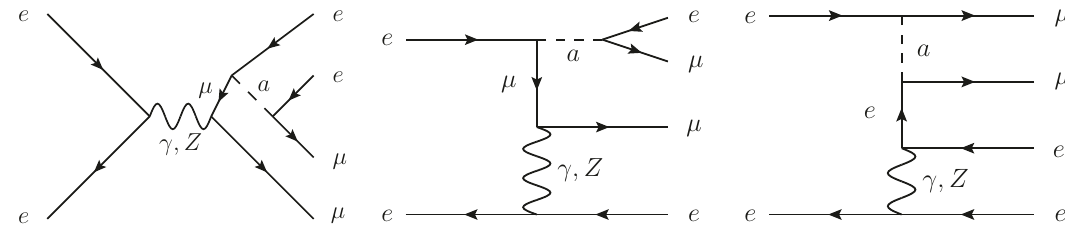
Figure 3 . Examples of Feynman diagrams for e + e (cid:0) ! (cid:22) (cid:6) (cid:22) (cid:6) e (cid:7) e (cid:7)